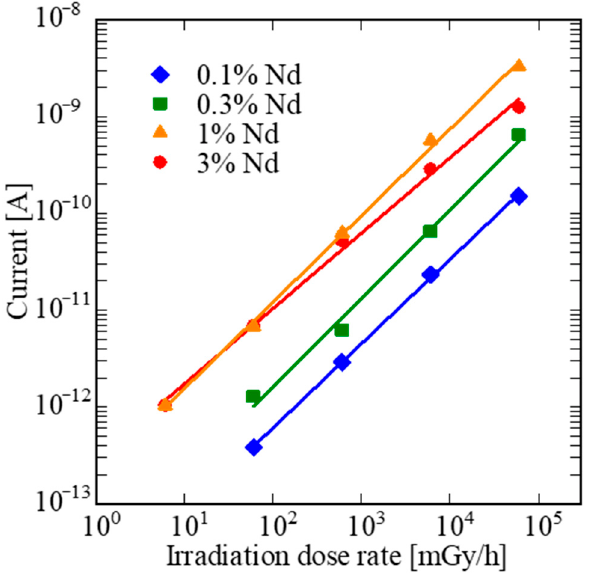
Figure 8. Relationships between dose rate and signal intensity of LaMgAl 11 O 19 :Nd.